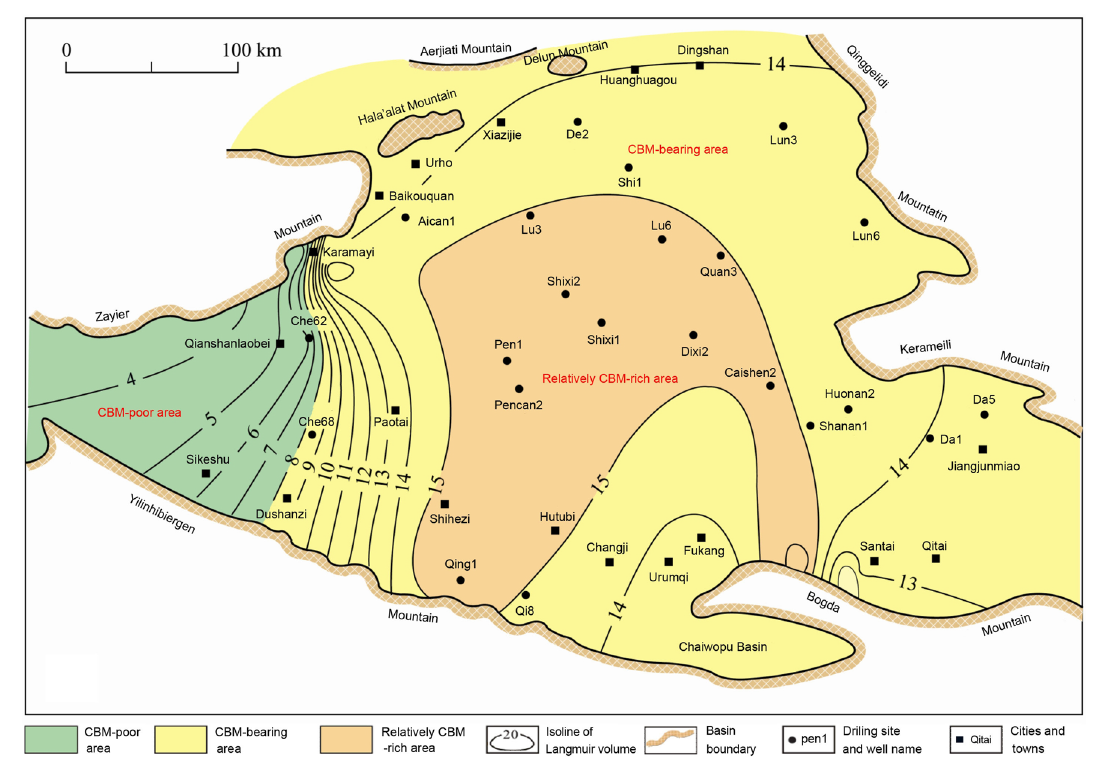
Fig. 6 Isogram of Langmuir volume distribution in the J